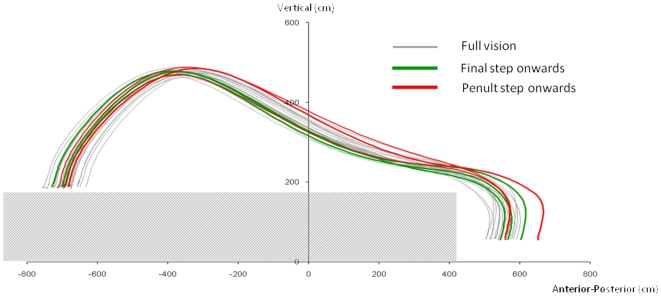
Lower visual field influence upon heel trajectory.Trajectories of the heel marker are shown for all trials from one subject for the step onto the lower floor level. Trajectories are plotted from lead-limb toe-off up to instant of contact with the lower level. NB, the heel trajectory for the condition when lvf was occluded at instant of penultimate step contact onwards, was beyond or towards the upper part (indicating higher heel clearance) of the variability boundaries of the full vision available throughout condition.